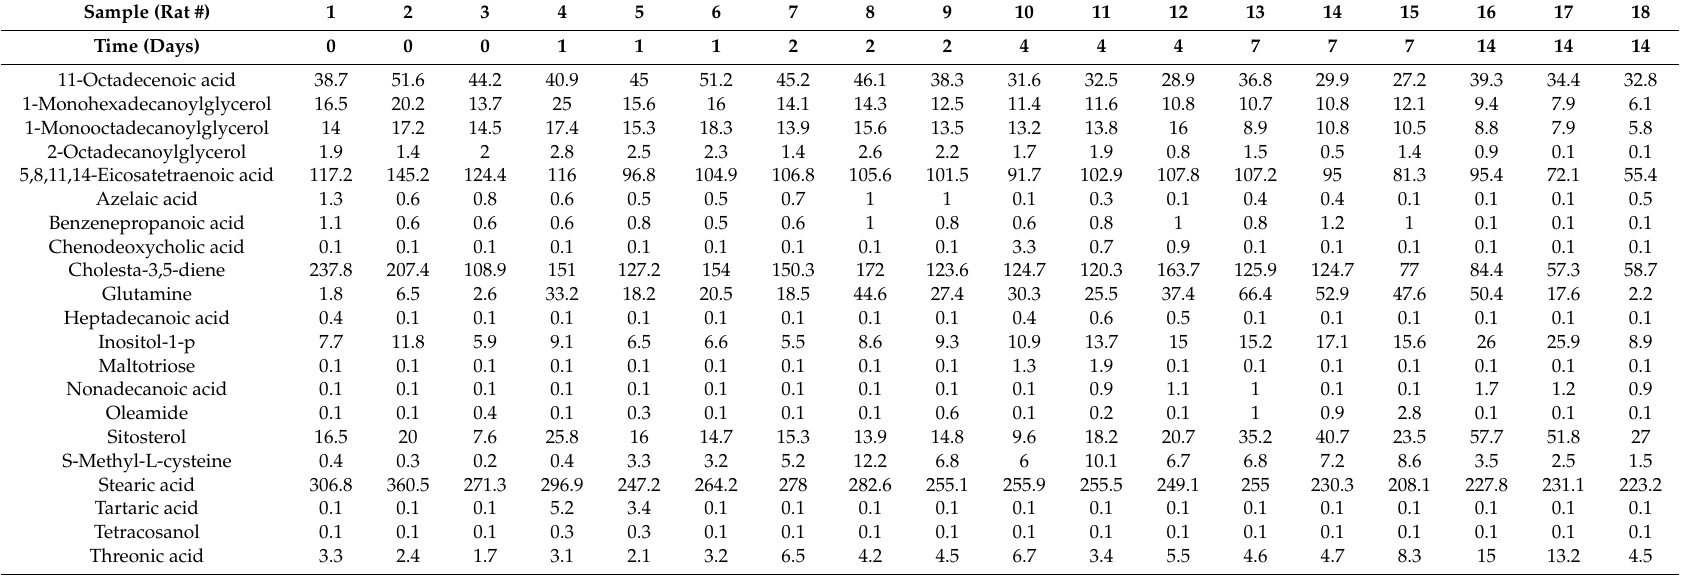
Table 1. Plasma metabolites that changed significantly throughout the broccoli